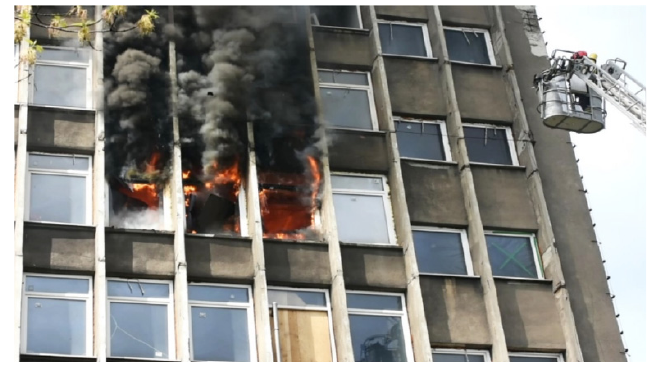
Figure 7. Windows breaking during the second test fire.